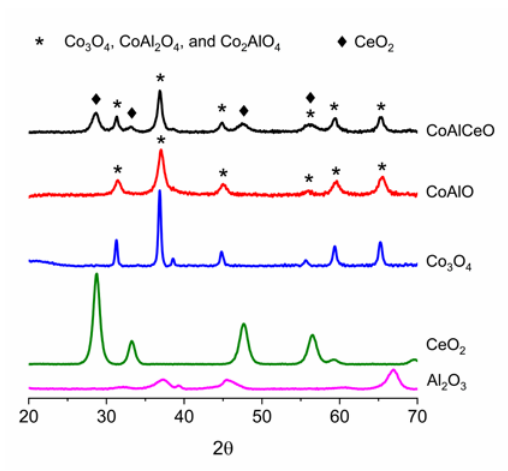
Figure 3. XRD di ff ractograms of calcined CoAl, CoAlCe, Co 3 O 4 , CeO 2 and Al 2 O 3 Figure 3. XRD diffractograms of calcined CoAl, CoAlCe, Co 3 O 4 , CeO 2 and Al 2 O 3 .